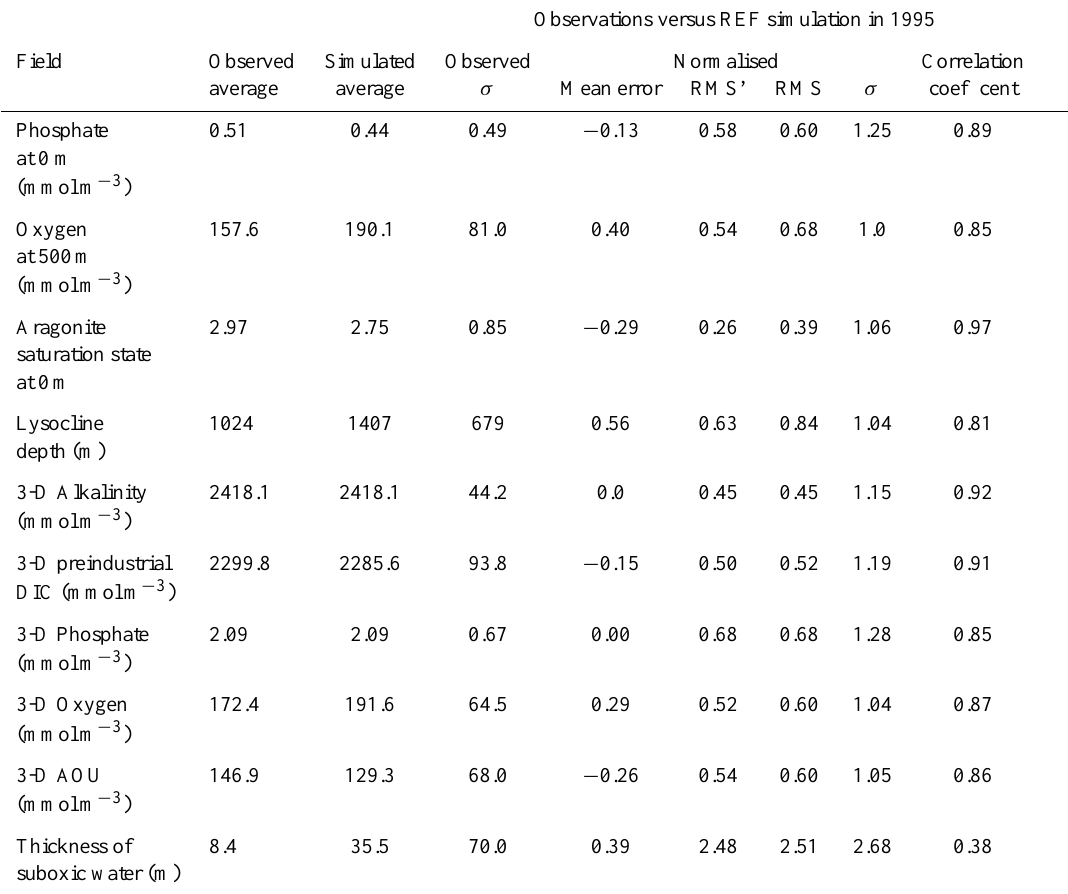
Table 3. Summary statistics of the comparison of the REF simulated fields with the observations shown in Fig. 1. All simulated fields are based on the REF 1995 values except for preindustrial dissolved inorganic carbon which comes from the REF 1850 simulation